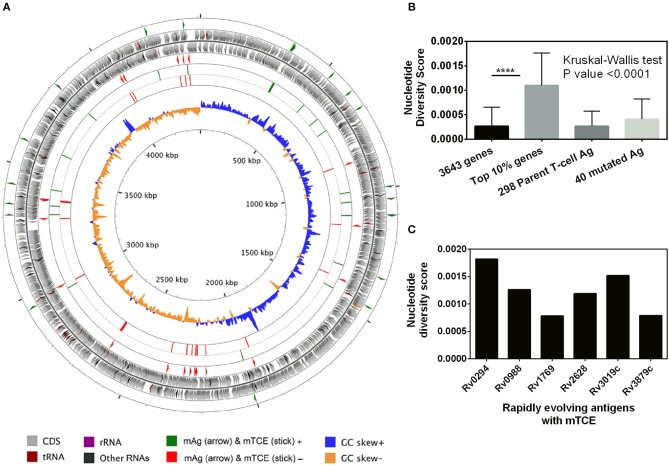
Genetic diversity of 79 Mtb strains from India. (A) The scale of the chromosome (in nucleotides, according to the reference Mtb strain H37Rv) is labeled on the innermost ring. From the outer to the inner concentric circle of the chromosome: Circles 1–2 and 3–4, genes with forward and reverse directions are indicated as right and left arrows, respectively. Circles 1 (green) and 4 (red) exemplify the locus of 40 mutated T-cell antigens, which encode mutated T-cell epitopes identified in this study. Circles 2–3 (gray) depict all genes from H37Rv. Circles 5 (green) and 6 (red) show the locus of 64 mutated T-cell, epitopes in the forward and reverse strands, lining their respective genes in circles 1 and 4, respectively. Circles 7 and 8 represents the GC skew of all the genes of H37Rv. (B) Bar graph showing nucleotide diversity scores of genes from different categories (****p-value < 0.0001). (C) Bar graph showing nucleotide diversity scores of six genes encoding mTCEs that fall within the top 10% of nucleotide diversity scores across all 3,643 genes (excluding repetitive genes) encoded by the 79 Mtb strains from India, and therefore designated as rapidly evolving.